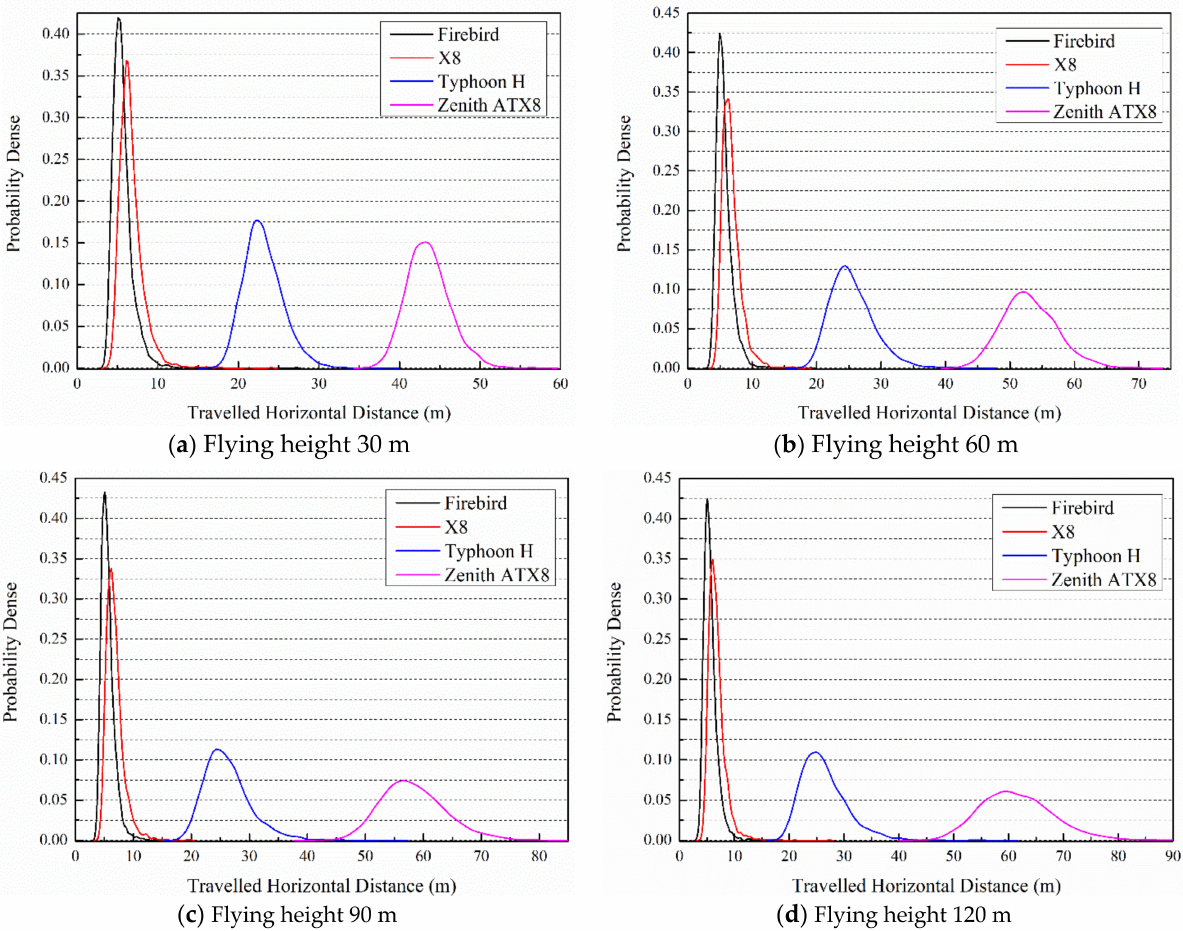
Figure 7. Probability estimation of travelled horizontal